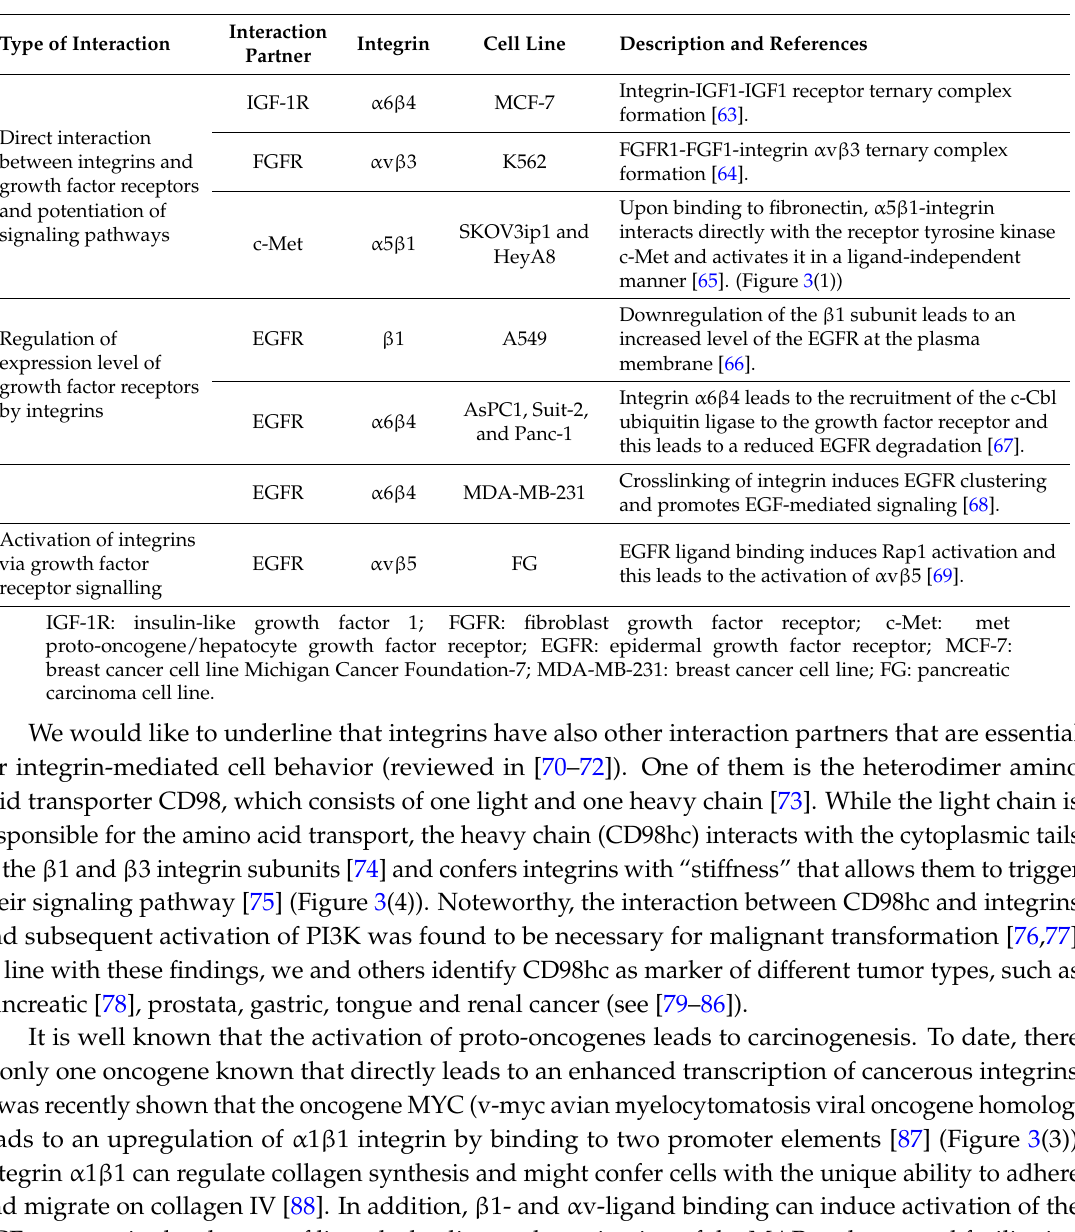
Table 1. Crosstalk between growth factor receptors and